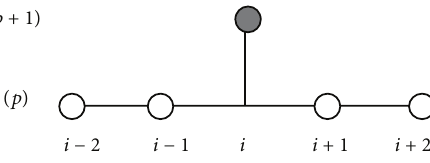
Figure 4: Computational molecule of the JAC4.